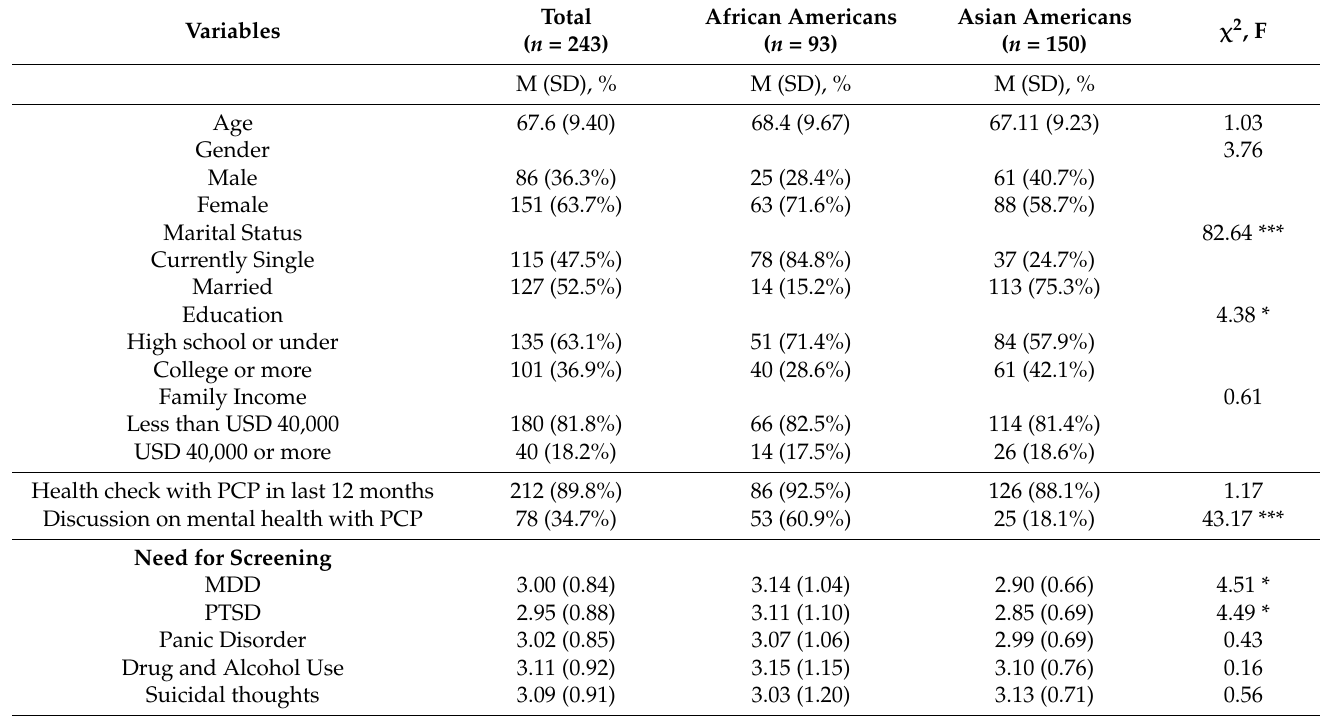
Table 1. Participant characteristics by ethnic